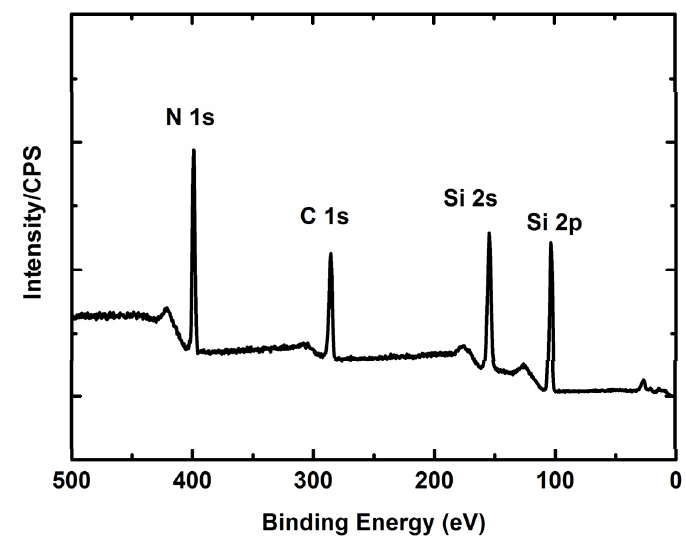
Figure 3. XPS survey of SiCN film.